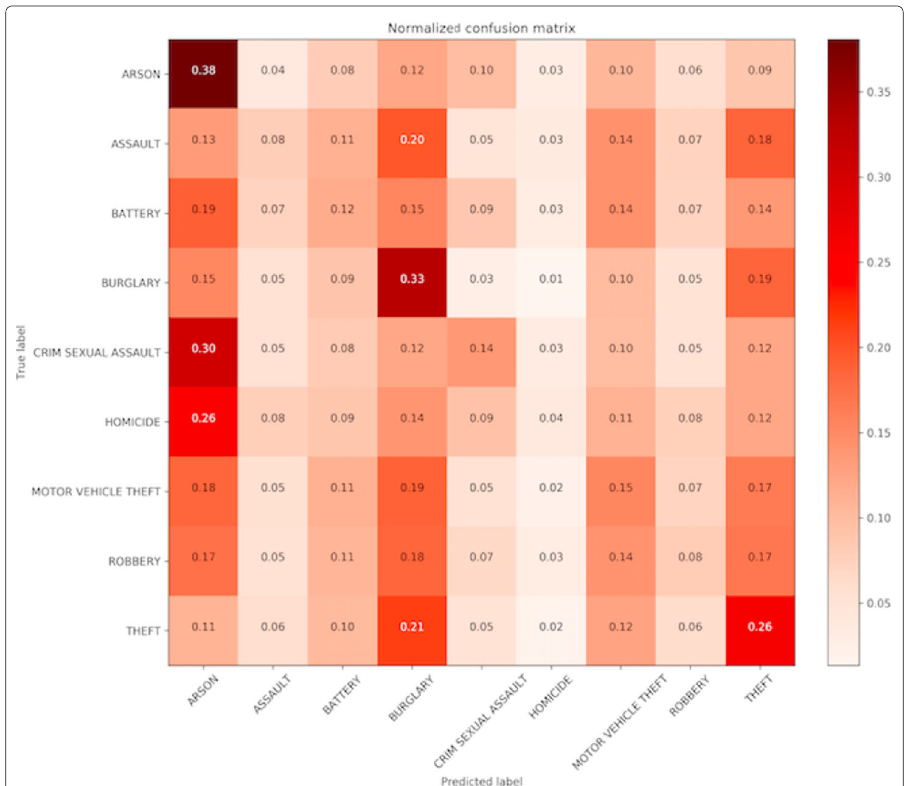
Fig. 6 Confusion matrix of Naive Bayes classifier. The matrix plots the performance of the classifier in correctly labeling each crime category